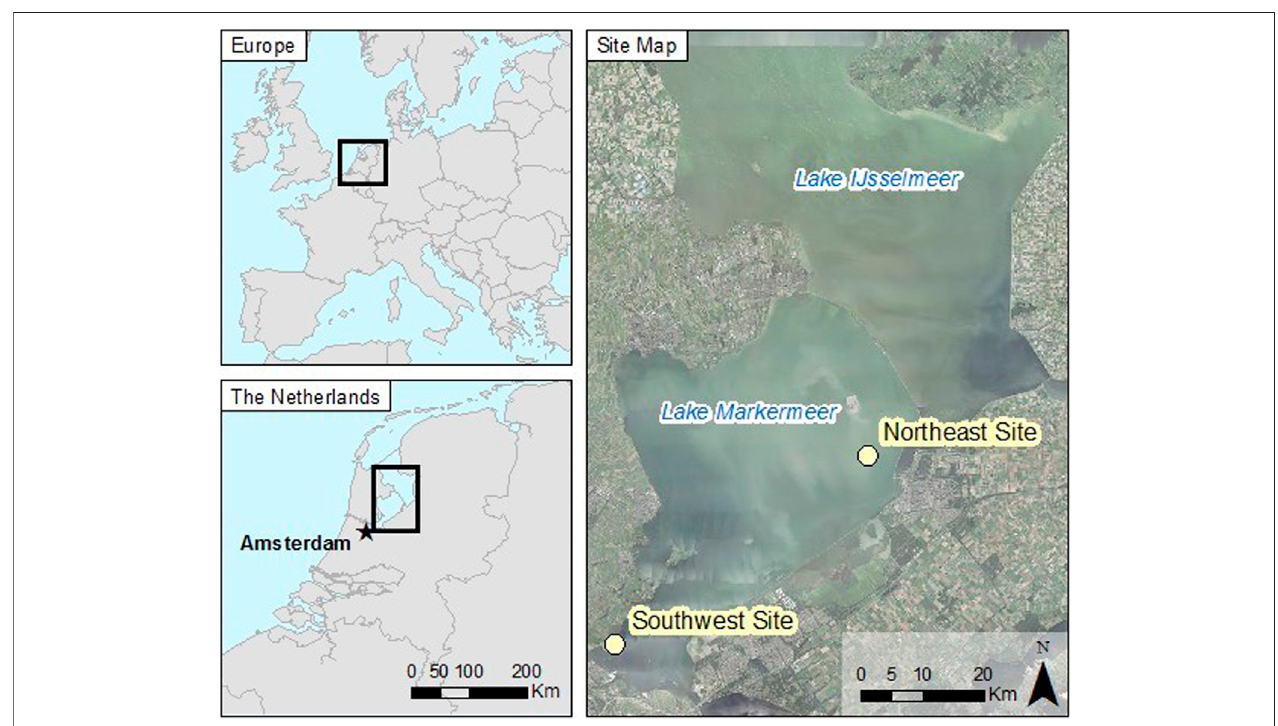
FIGURE 1 | Location of lake Markermeer (left) and sampling sites (right) . Source image: Publieke Dienstverlening Op de Kaart (PDOK) 2016.